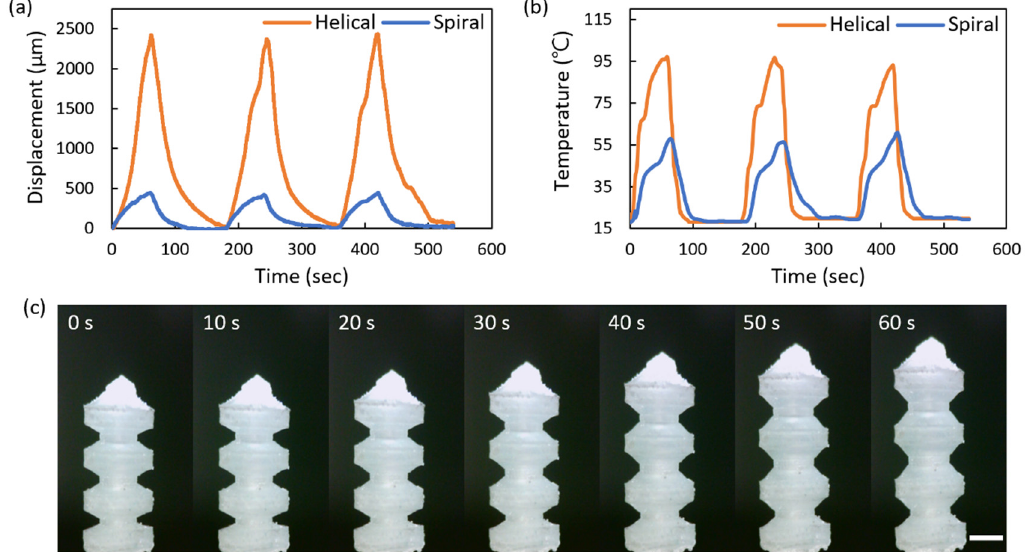
Figure 8. Performance of the thermopneumatic bellows actuator connected to the two-dimensional spiral and the three-dimensional helical inductor: ( a ) Real-time displacement of the actuators. ( b ) Temperature change of the outer surface of the actuators. ( c ) The captured driving actuator connected to the three-dimensional helical inductor. The scale bar indicates 1 mm.